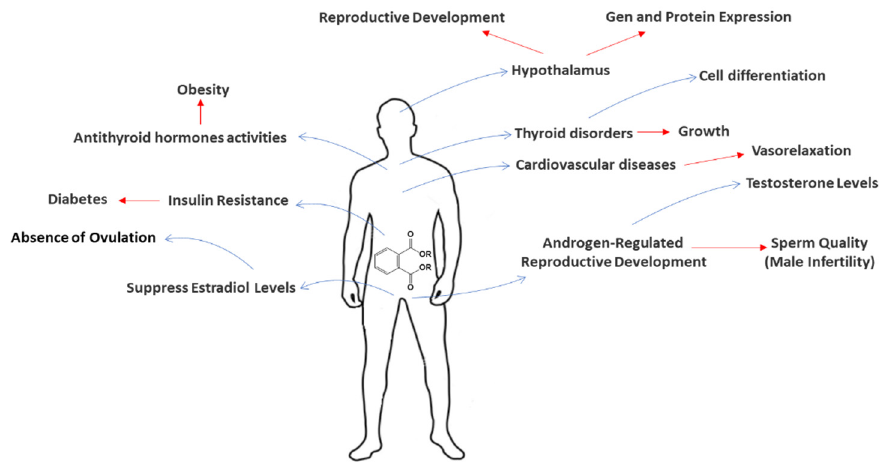
Figure 3. Main hormonal action of high levels of PAEs associated with humans.